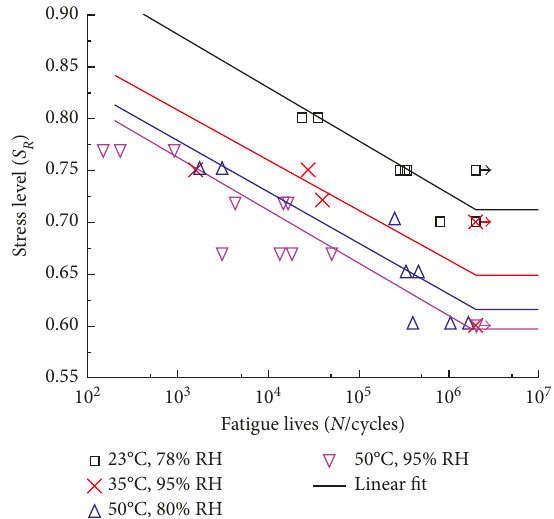
Figure 4: Experimental S environments and cyclic loads. Table 5: Coefficients A